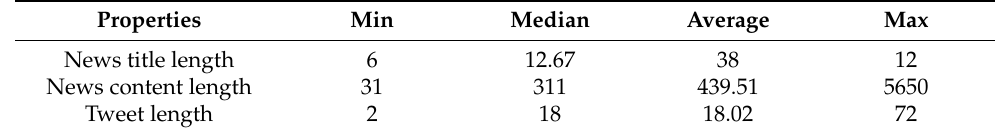
Table 2. Text length statistics of dataset.